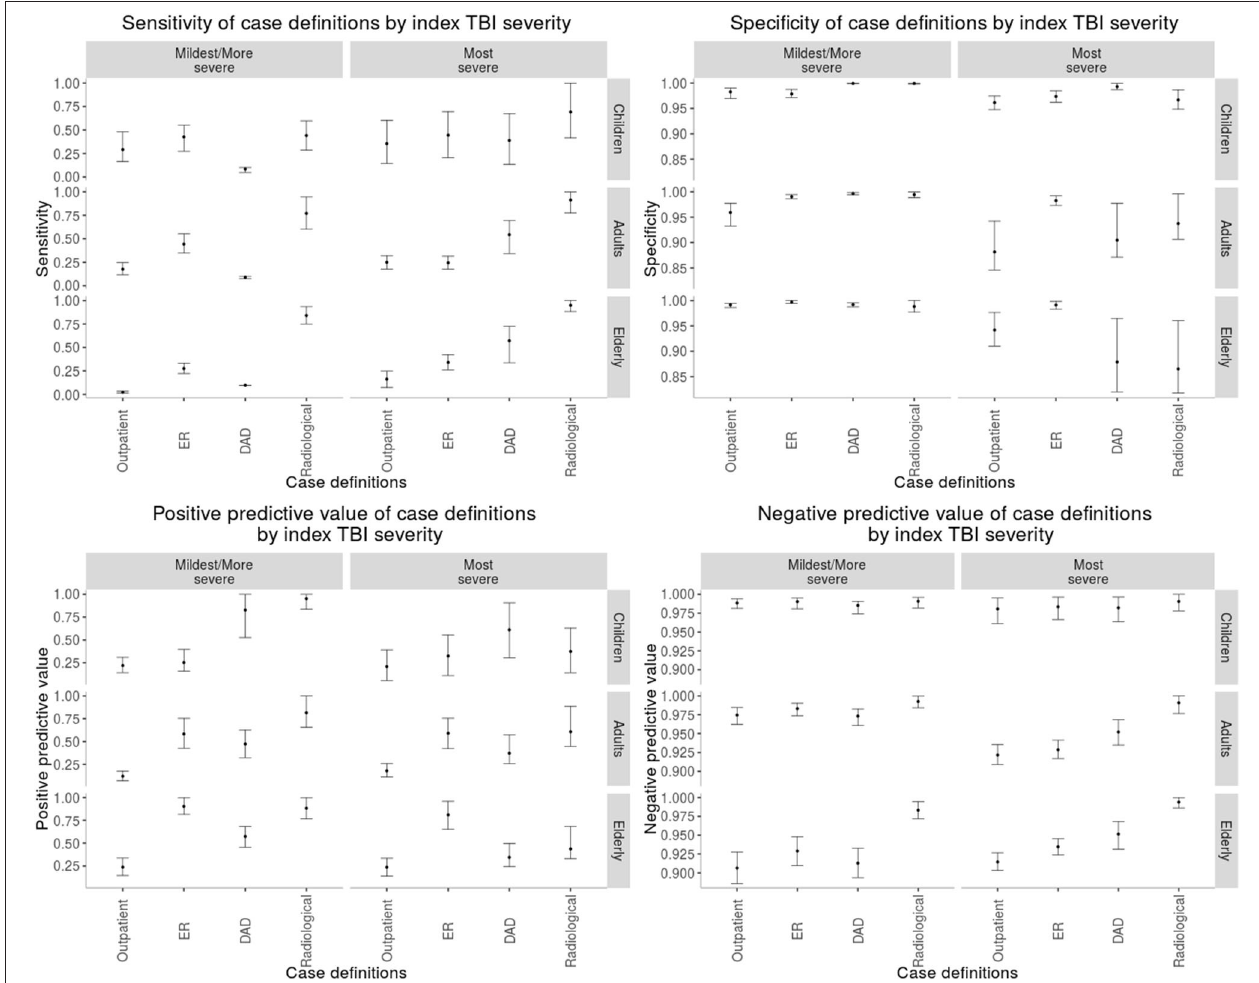
FIGURE 1 | Performance of each case definition to perform rTBI surveillance stratified by each age group and incident TBI severity. “Outpatient,” outpatient claims; “DAD,” discharge abstract database; “Radiological,” radiological examination claim in the context of any trauma diagnosis.